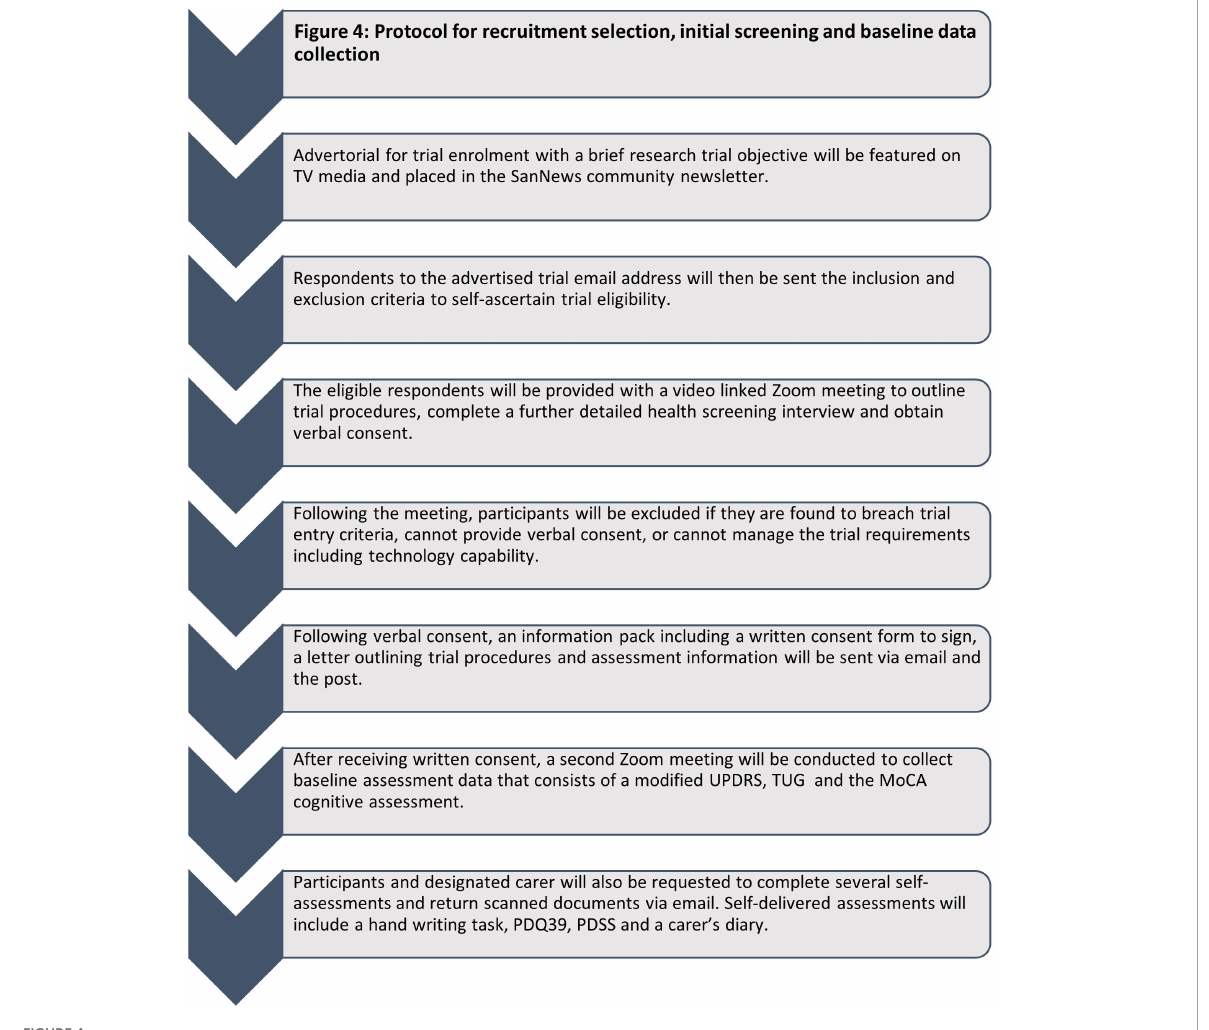
FIGURE4 Protocol for treatment and